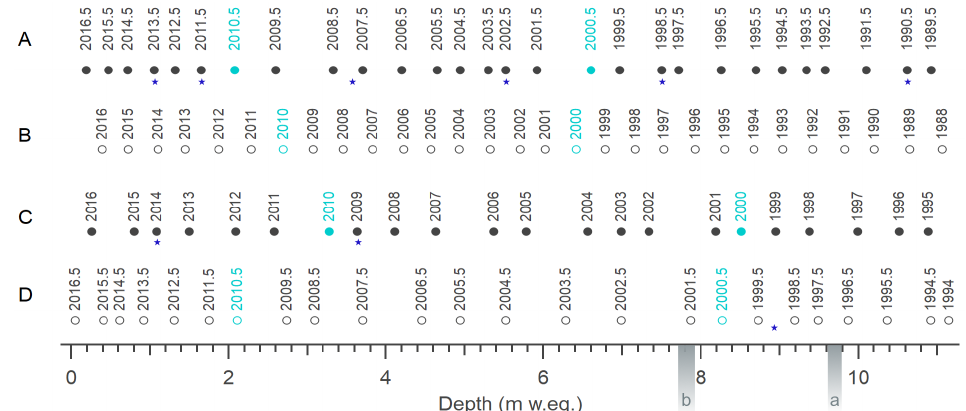
Figure 11. Comparison of the four age scales based on δ 18 O ( A ), NO 3 − record ( B ), marine ion concentrations ( C ), and nssSO 42 − :ssNa + ratio ( D ); integer years refer to the respective January, winter-based dating approaches point to July and are denoted with a ‘.5’ suffix; 2010 and 2000 highlighted in turquoise as reference years; blue stars point out uncertain years; grey bars indicate horizons of (a) elevated SO 42 − :NO 3 − ratio, and (b) cryptotephra discussed in the next Section 3.5.